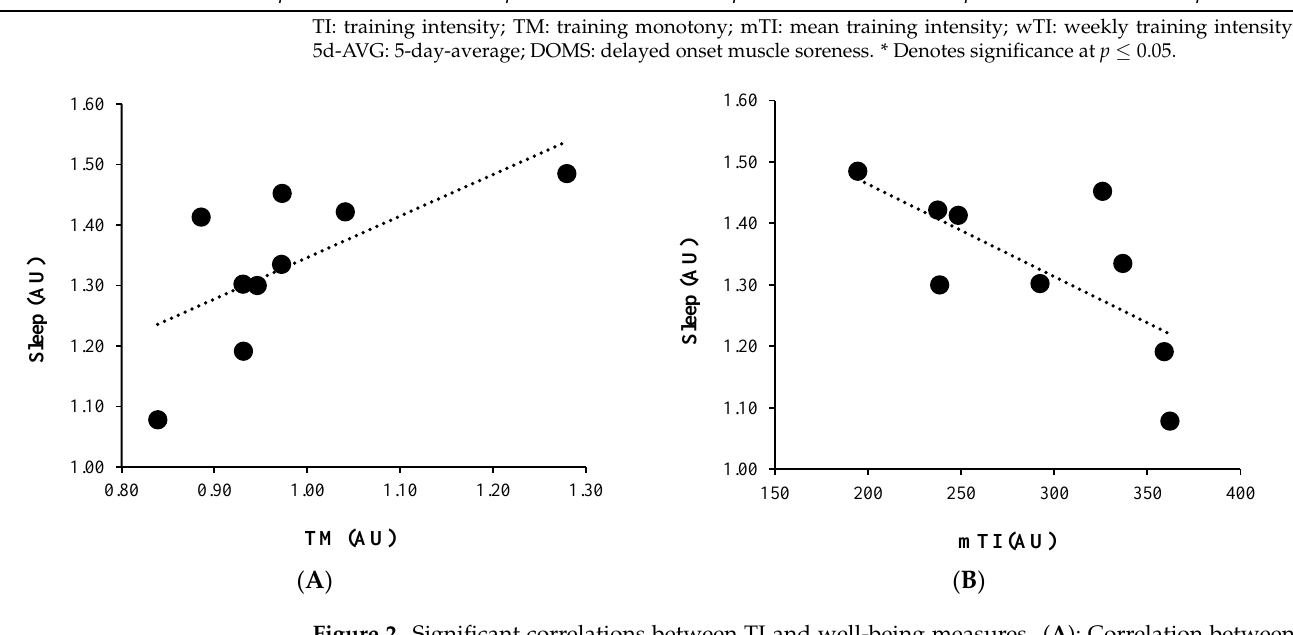
Figure 2. Significant correlations between TI and well-being measures. ( A ): Correlation between TM and sleep quality; ( B ): Correlation between mTI and sleep quality. TM: training monotony; mTI: mean training intensity; AU: arbitrary units.